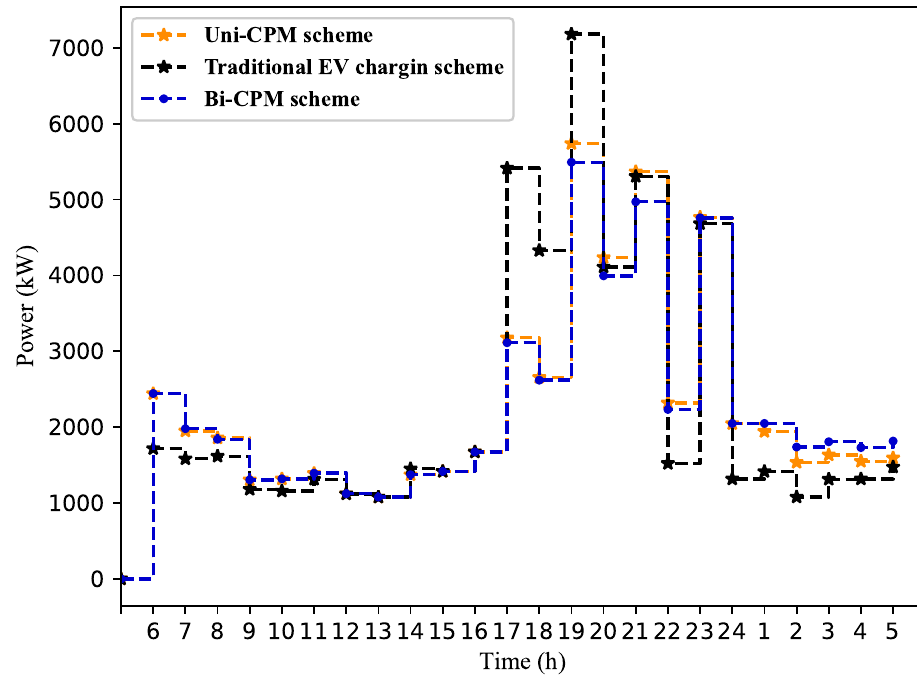
Figure 5. Total grid power consumption for the three schemes.